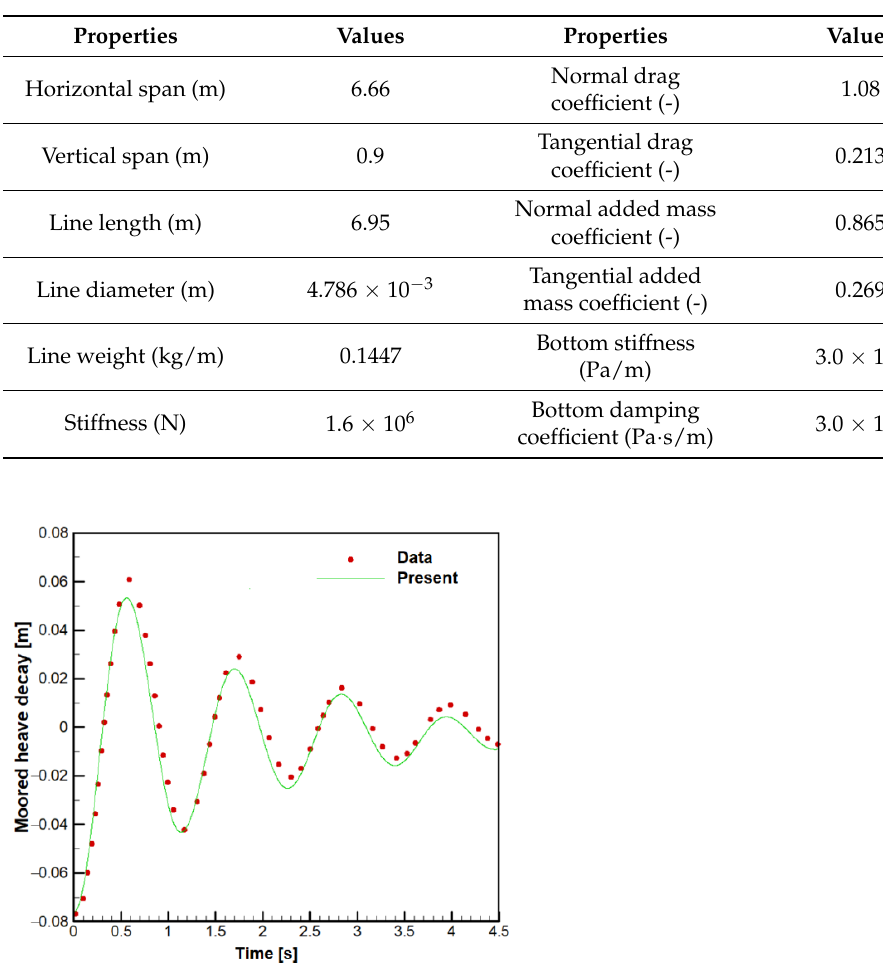
Table 2. Mooring properties and environmental parameters for moored decay test.